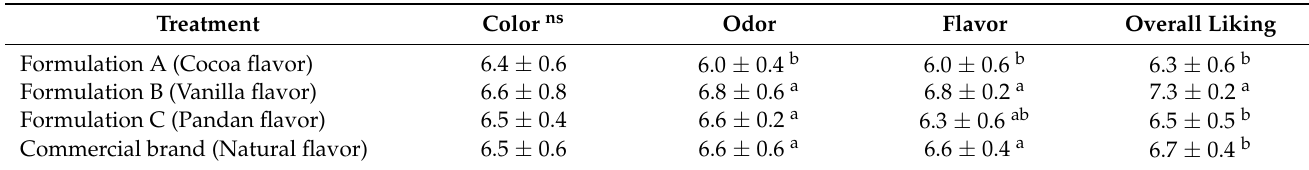
Table 4. Sensory properties of instant beverage from BR powder in various